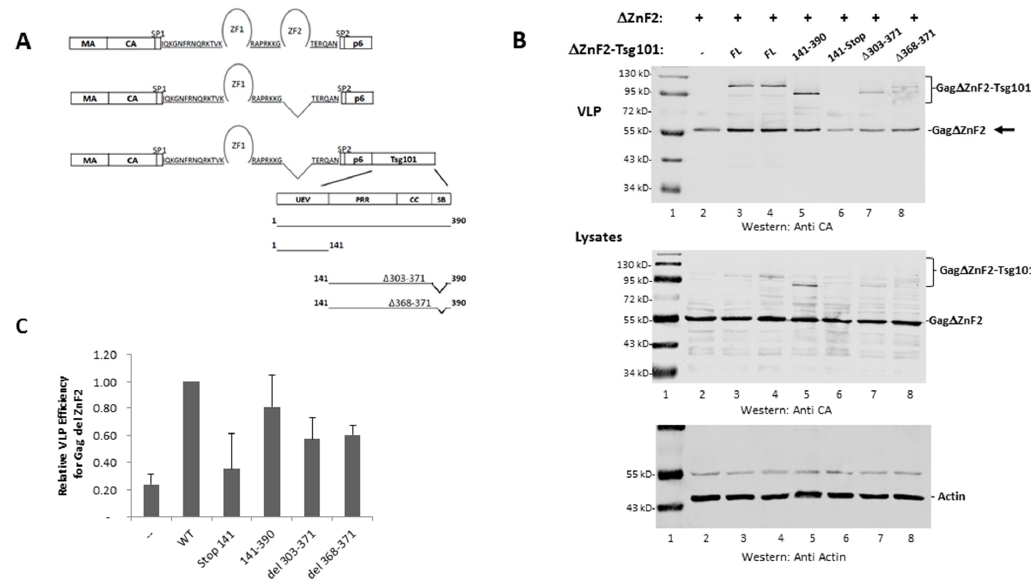
Figure 5. Vps28 binding is a critical event for Δ ZnF 2 rescue. ( A ), Schematic representation of Gag, Gag- Δ ZnF 2, and chimeric Gag- Δ ZnF 2 -Tsg101 constructs used in this study. ( B ), Gag- Δ ZnF 2 was transfected alone or with chimeric Gag- Δ ZnF 2 -Tsg101 and examined by Western analysis for release of the VLPs assembled from Gag- Δ ZnF 2 (see arrow). The cell lysate signal was normalized for total protein content using the cellular protein actin as an internal marker. ( C ), Quantitative analysis. Efficiency of VLP release was measured as (Gag- Δ ZnF 2 VLP/(Gag Δ ZnF 2 VLP + Gag- Δ ZnF 2 in lysate)) relative to Gag WT. As judged by Student’s t-test, Tsg101 Δ 303-371 and Δ 368-371 differed from the chimera with Tsg101 sequences 141-390 ( p <0.05).